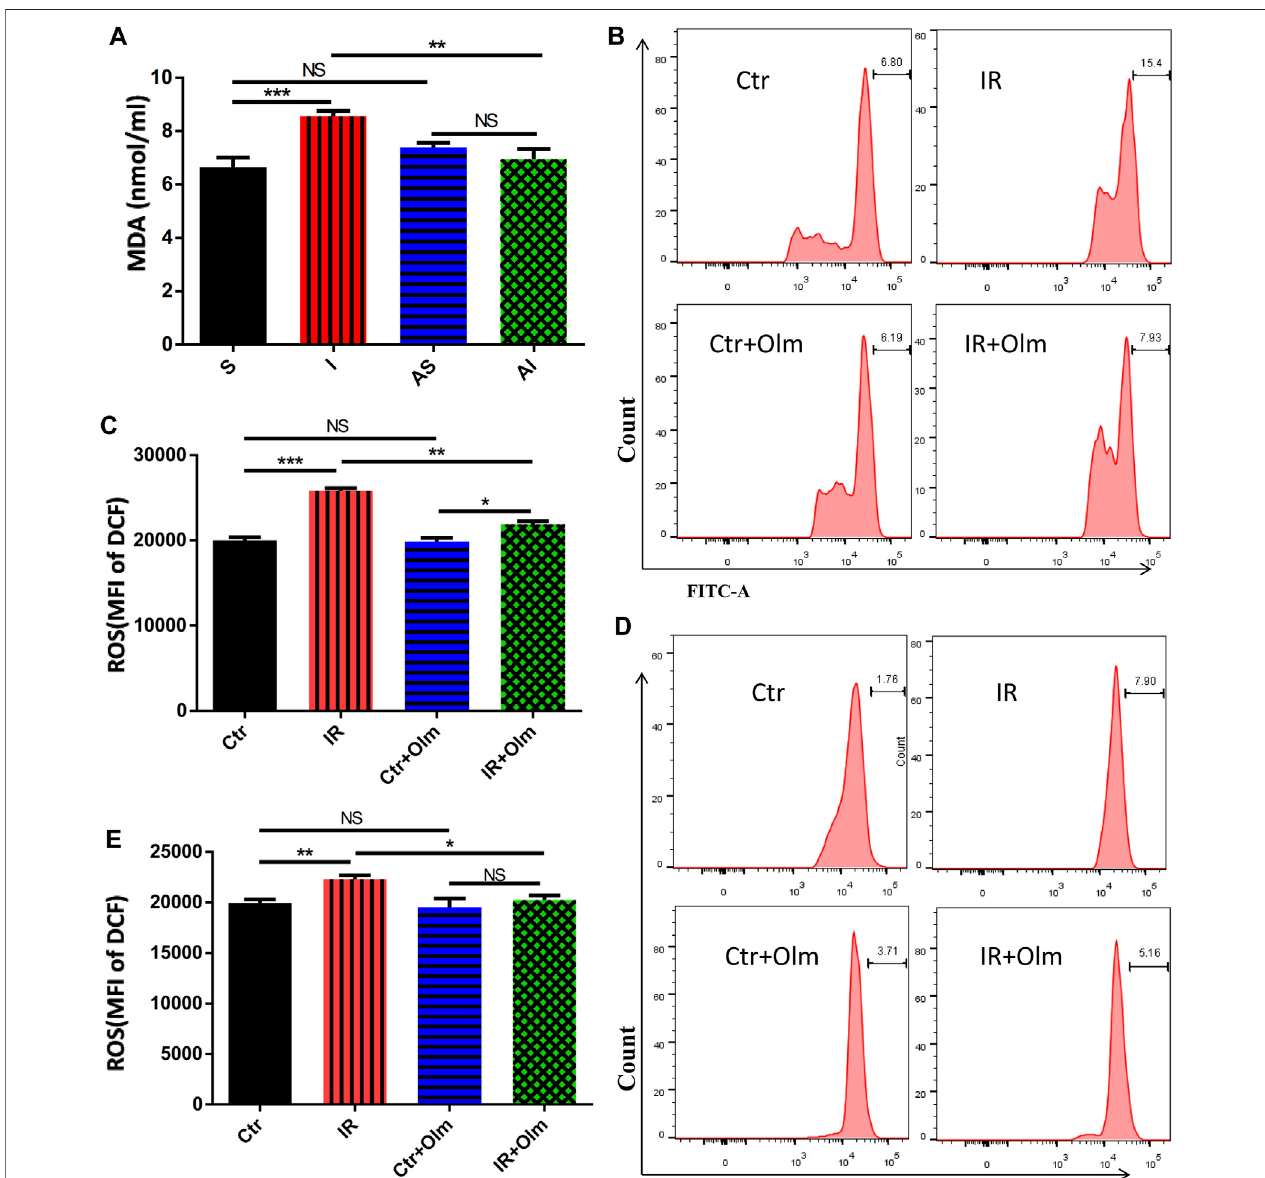
FIGURE2| Olmesartan(Olm)inhibitsSLVinducedacutelunginjurybyinhibitingoxidativestress.MDAlevelinserum (A) TheproductionofROSwasdeterminedby fl owcytometry (B – D) ( n =3).RepresentativeimagesofHUVECs (B) .RepresentativeimagesofA549cells (C) .TheaverageMFIofHUVECs (D) .TheaverageMFIofA549 cells (E) .Dataarepresentedasthemean±standarderrorofthemean.NS:notsigni fi cantlydifferent.* p < 0.05,** p < 0.005,*** p < 0.001,**** p < 0.0001.SLV:single-lung ventilation; Olm: olmesartan; S: sham; AS: ARB + sham; I: injury; AI: ARB + injury; Ctr: control; IR: ischemia reperfusion; MDA: malondialdehyde; MFI: mean fl uorescence